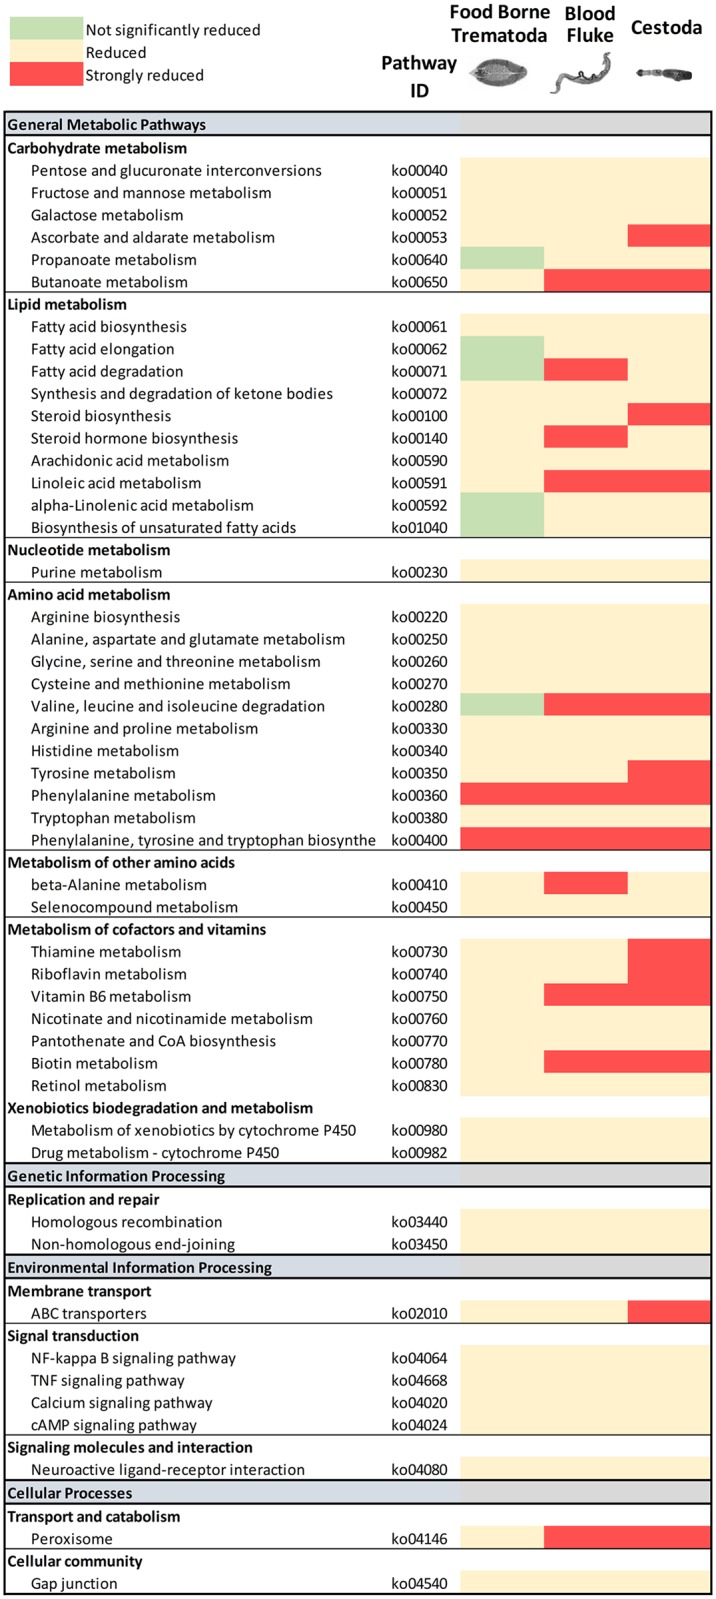
Metabolic pathway reduction in parasitic flatworms.The global number of proteins assigned to different metabolic pathway was compared between different parasitic flatworms, the free-living planaria and cattle predicted proteomes. Those pathways showing a significant reduction in the parasitic species in relation to those present in planaria are indicated (strongly reduced: less than 30% conservation; reduced: conservation between 30 and 80%; not significantly reduced: more than 80% conservation). While in general several pathways are reduced in all parasitic species, some pathways are differential between food borne trematodes (F. hepatica, O. viverrini, C. sinensis), blood flukes (S. mansoni and S. japonicum) and cestodes (E. multilocularis, H. microstoma and T. solium). Most notably some lipid metabolism and amino acid pathways (i.e. aliphatic amino acid degradation) are not reduced in FBT (green) while they are reduced in the other groups. In general, FBT seem to be less constrained than blood flukes, with cestodes being the most restricted metabolically.